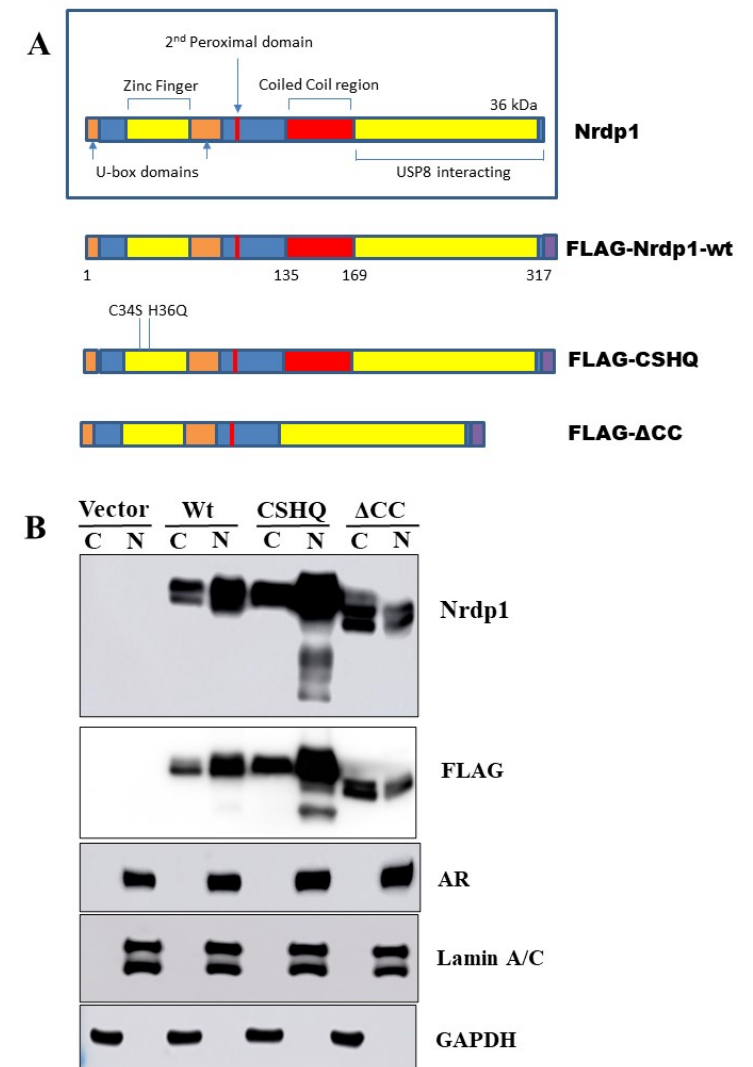
Figure 4. Overexpression of NRDP1 through transfection with various NRDP1 constructs caused high levels of nuclear NRDP1 expression. Three FLAG-tagged constructs were used to allow for manipulation of NRDP1 levels and to help determine whether interaction between AR and NRDP1 is possible; wildtype NRDP1 (Wt), NRDP1-CHSQ (CSHQ), and NRDP1- Δ CC ( Δ CC) ( A ). The CSHQ construct harbors two point mutations in the receptor binding region (RING finger domain) which cause a dramatic reduction in the ability of NRDP1 to auto-ubiquitinate and to facilitate ubiquitination of target proteins. The Δ CC construct is missing the coiled coil domain this prevents NRDP1 oligomerization, a step that is required for efficient NRDP1 auto-ubiquitination to occur, however, ubiquitination of other NRDP1 target proteins by Δ CC is still possible. Transfection of LNCaP cells with these constructs (3 µg per 100 dish, 48 h) caused a dramatic increase in NRDP1 expression and high levels of nuclear NRDP1 were observed ( B ). Detailed information about Western Blot can be found at supplementary materials.